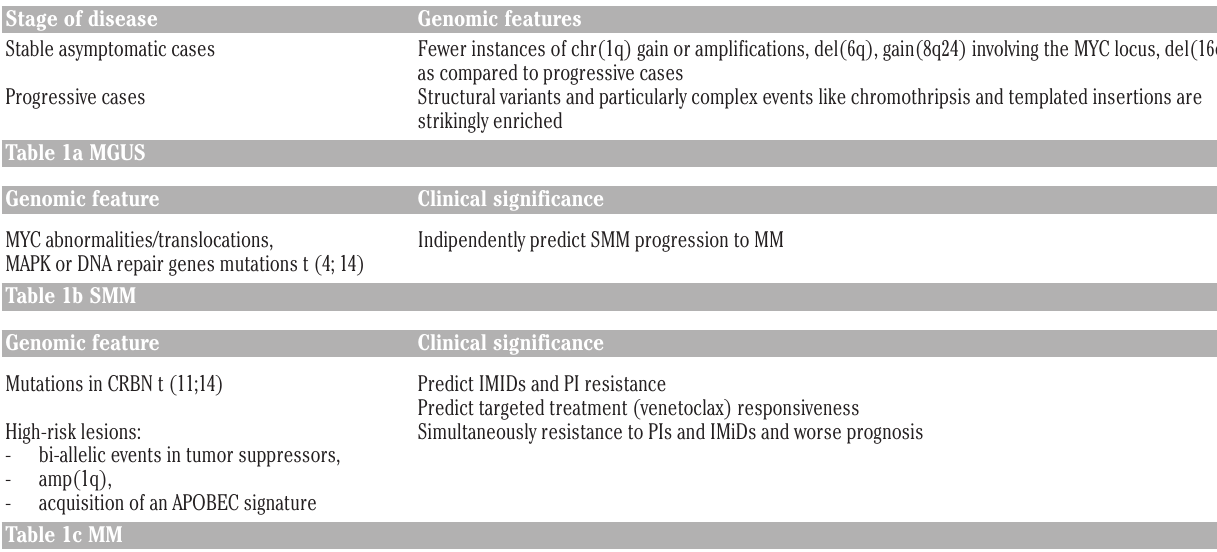
Table 1. Main genomic features of MGUS (1a), SMM (1b) and MM (1c). Stage of disease Genomic features